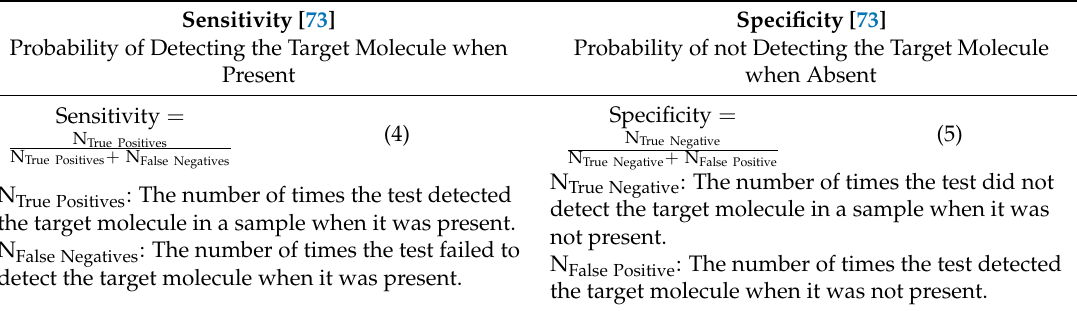
Table 1. Definition of sensitivity and